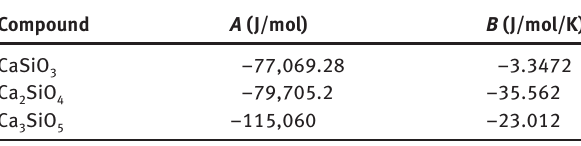
Table 2: Gibbs free energy of formation for mCaO·nSiO 2 (